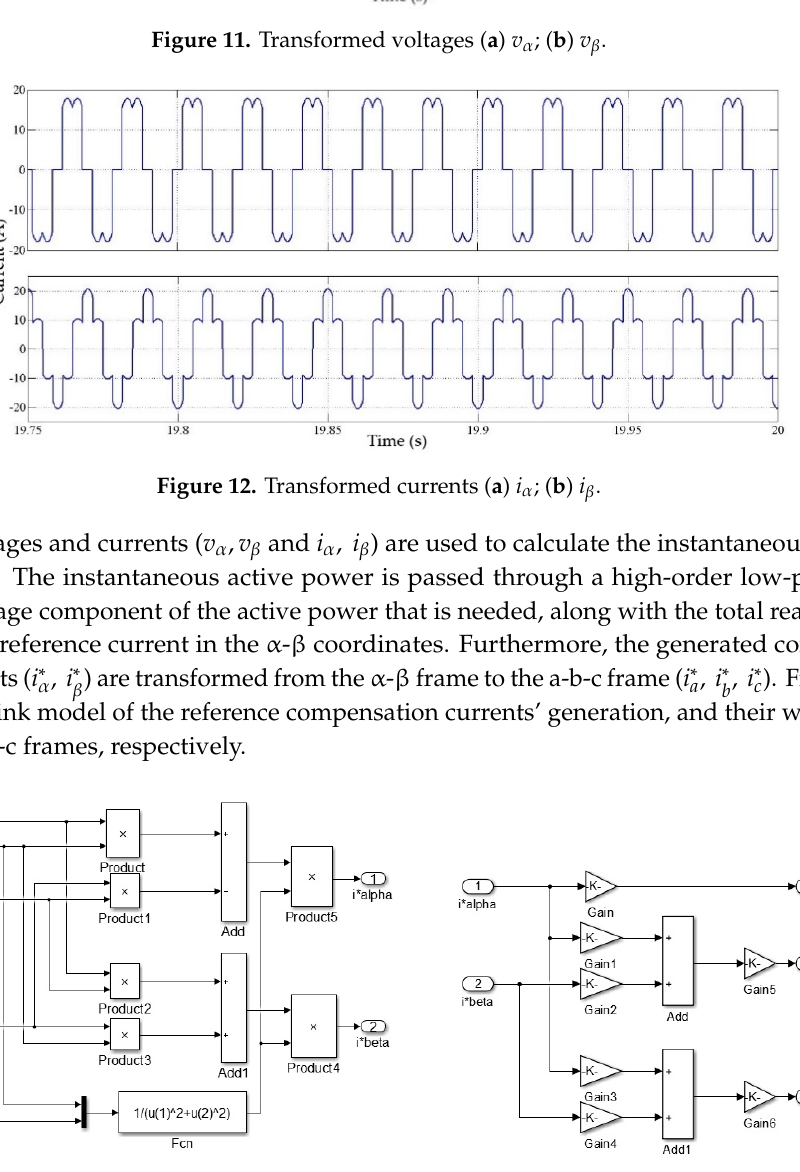
Figure 17. After compensation source current FFT analysis. Figure 13. Simulink reference current generation in ( a ) the α - β frame; ( b ) the a-b-c Figure 13. Simulink reference current generation in ( a ) the α - β frame ; ( b ) the a-b-c frame.